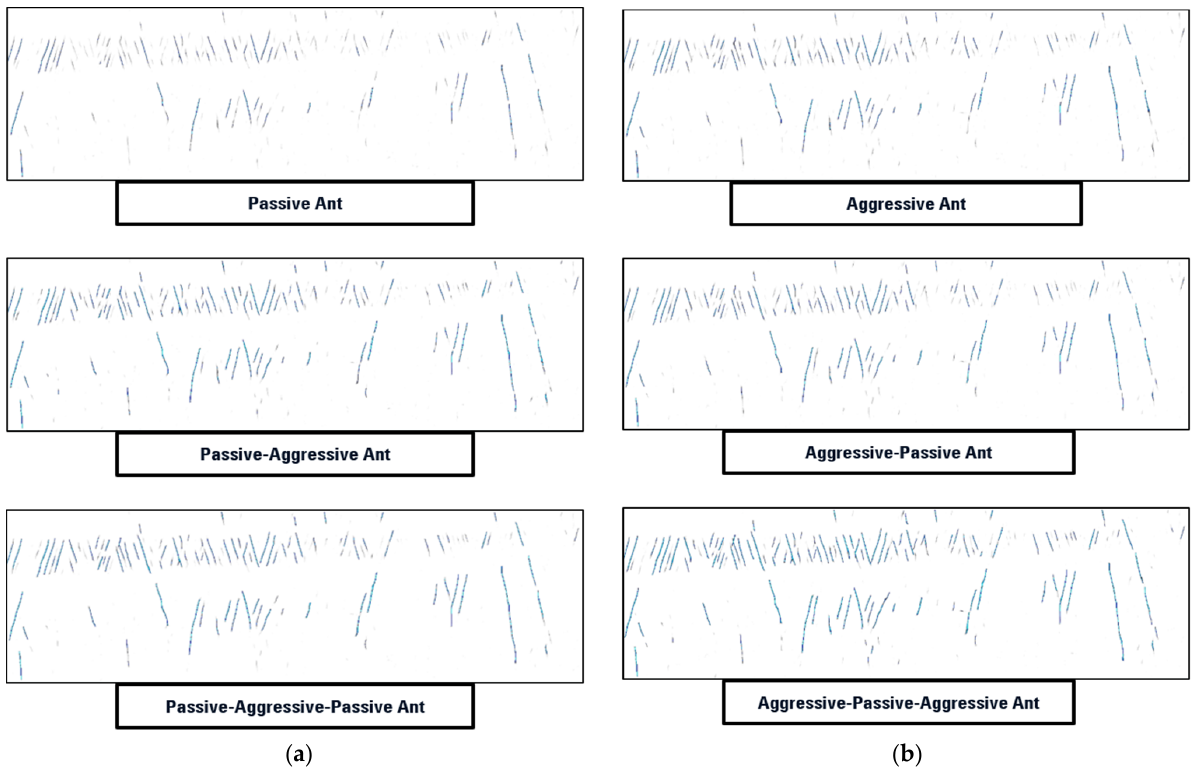
Figure 6. Second edge enhancement with cross-applying using the ant tracking attributes. In the ( a ) aggressive–passive– aggressive sequence, the edges of the small faults are more enhanced, and, in the ( b ) passive–aggressive–passive sequence, the edges of the major faults are enhanced.